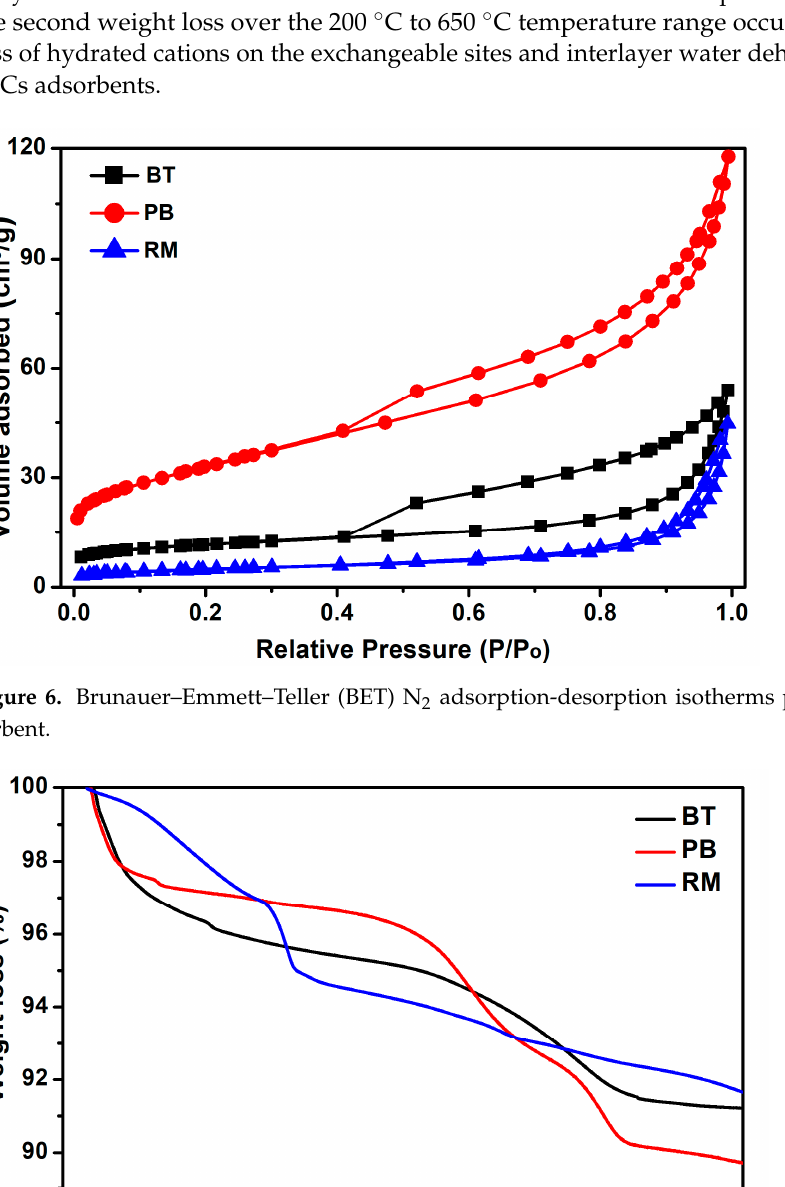
Figure 8. Effect of contact time on malachite green (MG) adsorption.